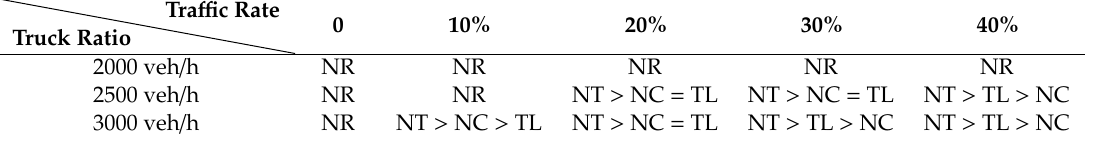
Table 3. Traffic scheme recommendation for evacuation using the contraflow strategy.